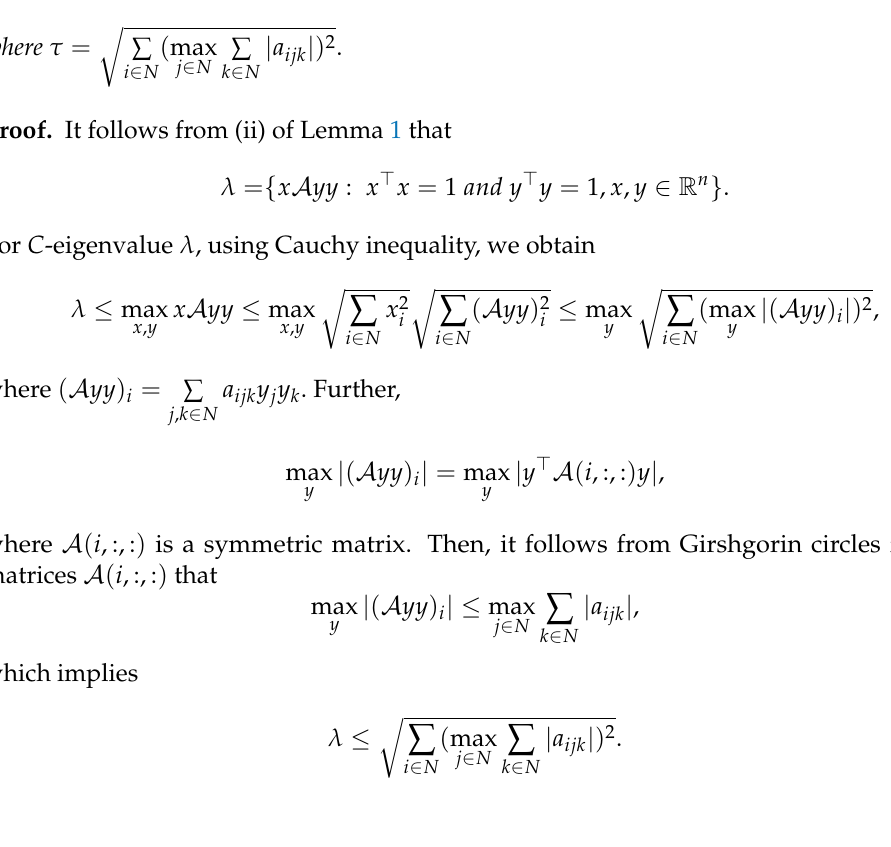
Q 3 and A KBi 2 F 7 2 F 7